Question: Express in one sentence what the figure is showing.
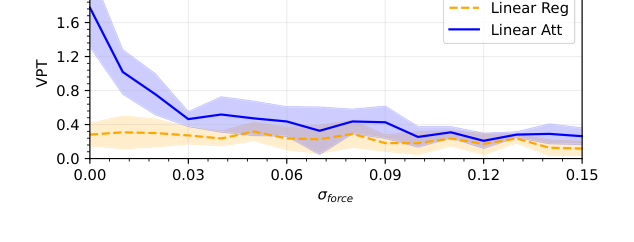
Answer: (a) NRMSE and (b) VPT for classical linear regression (dashed orange line) and attention-enhanced reservoir computing (solid blue line) with varying coupling strength σforce of UCTLS. The shaded areas depict the standard deviations of NRMSE and VPT over ten time series. The photonic reservoir size is set to N = 50 nodes.